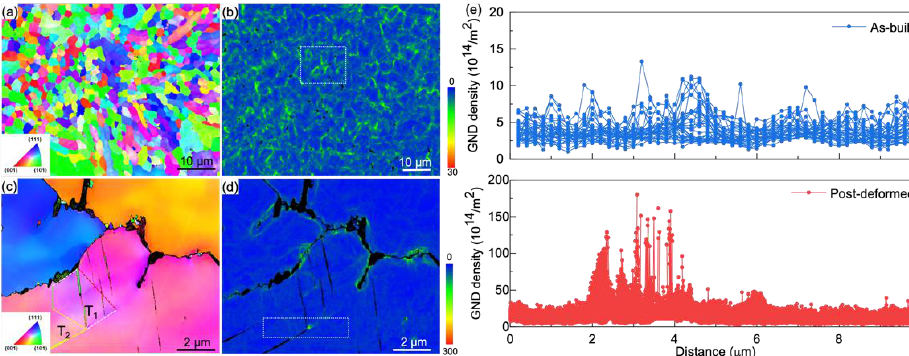
Figure 2. Microstructures of as-built and post-mortem samples. ( a ) The initial EBSD orientation map in the LD-TD plane. ( b ) Distribution of geometrically necessary dislocations. ( c ) The morphology of a post-mortem sample and ( d ) its GNDs distribution. ( e ) GNDs distribution profiles of the selected areas in ( b , d ), respectively.